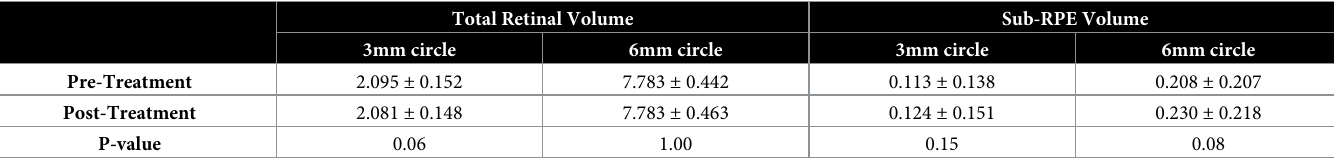
Table 4. Total retinal volume and sub-RPE volume before and after SNL treatment within a 3mm-diameter and 6mm-diameter annulus centered on the